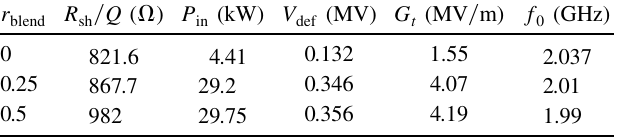
TABLE V. Effect of rounding the CSRR metallization edges on deflector performance characteristics. The other deflector ¼ 14 , r ¼ 7 , w ¼ 1 : 5 , s ¼ geometrical parameters are: r x z